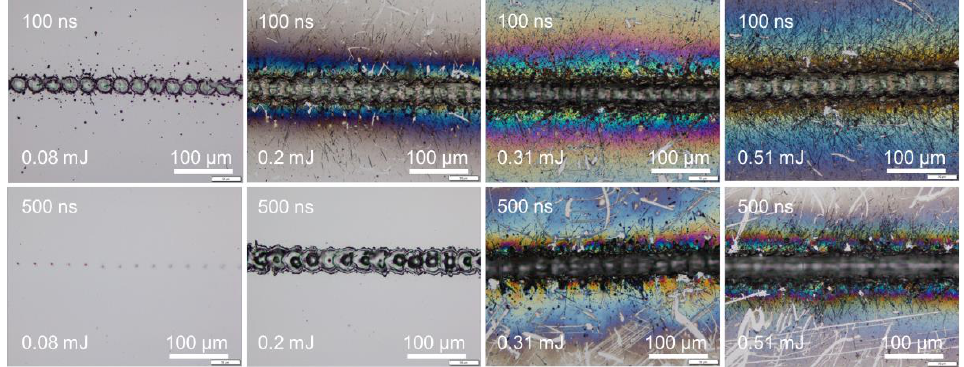
Figure 11. Surface morphologies showing a stronger edge thermal effect and more debris along the scanning line at increasing pulse energy fluence at 400 mm/s scanning speed.